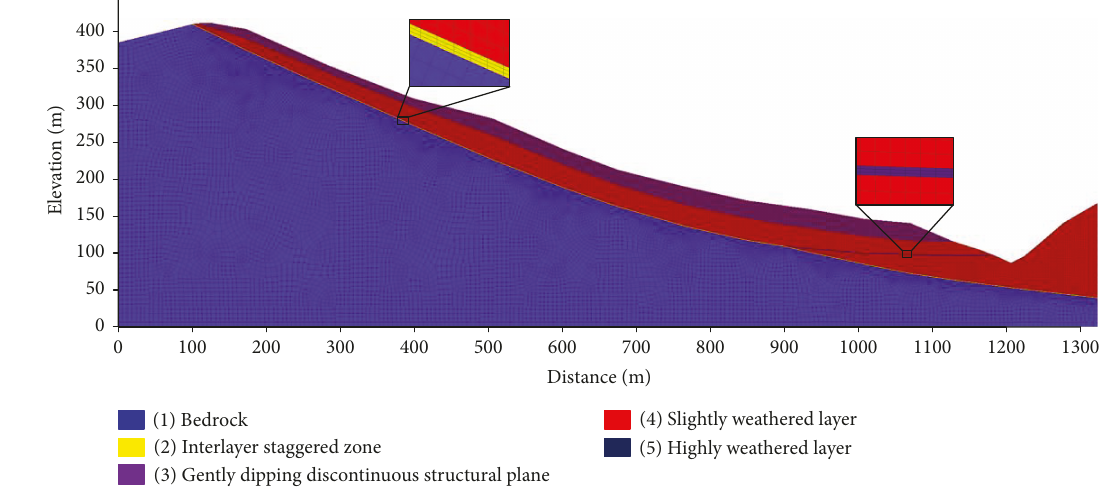
Figure 6: Mesh model of the Qianjiangping slope. Table 1: Physical and mechanical parameters of